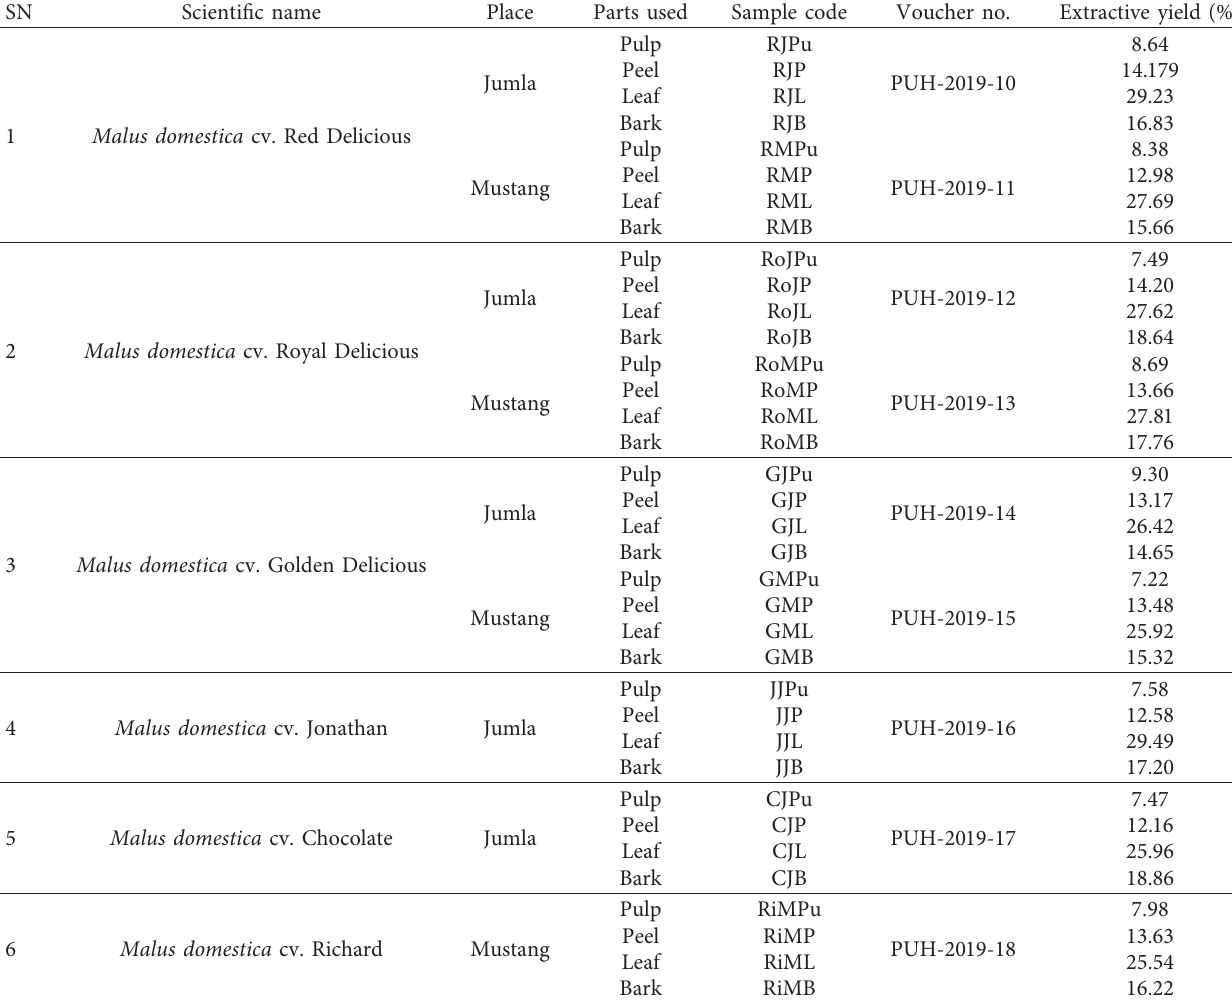
Table 1: Plant extract of six distinct apple cultivars and corresponding extractive yield of methanol extract. SN Scientific